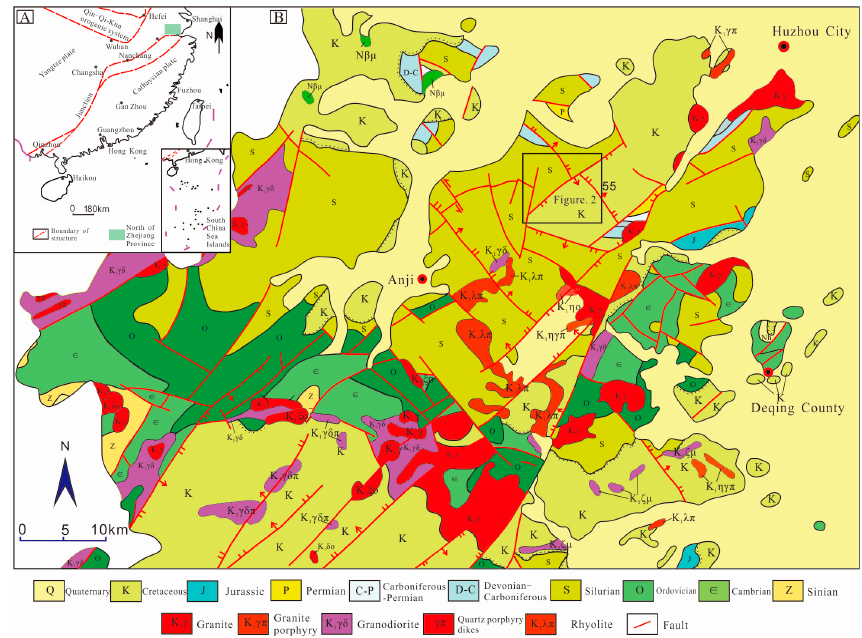
Figure 1. ( A ) Geotectonic position and ( B ) a regional geological sketch in northern Zhejiang Province (according to ref. [22]).